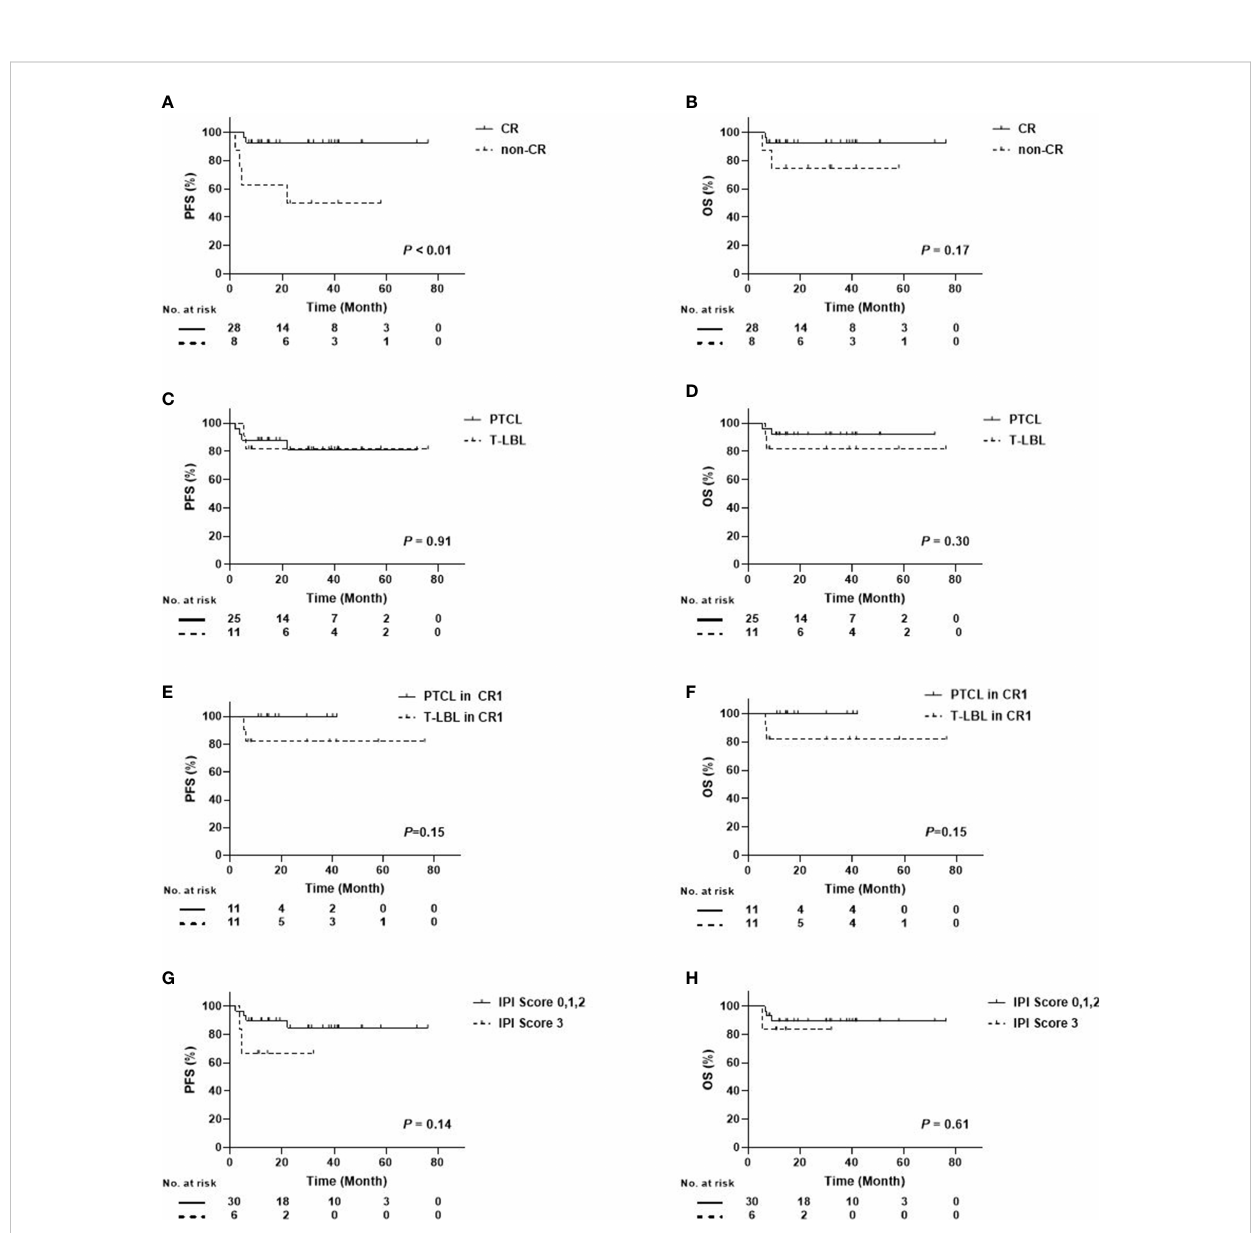
FIGURE 3 Survival Curves Between Different Subgroups in Patients with PTCL/T-LBL (A) PFS Between CR and Non-CR; (B) OS Between CR and Non-CR; (C) PFS Between PTCL and T-LBL; (D) OS Between PTCL and T-LBL; (E) PFS Between PTCL in CR1 and T-LBL in CR1; (F) OS Between PTCL in CR1 and T-LBL in CR1; (G) PFS Between IPI score 0, 1, 2, and 3; (H) OS Between IPI score 0, 1, 2, and